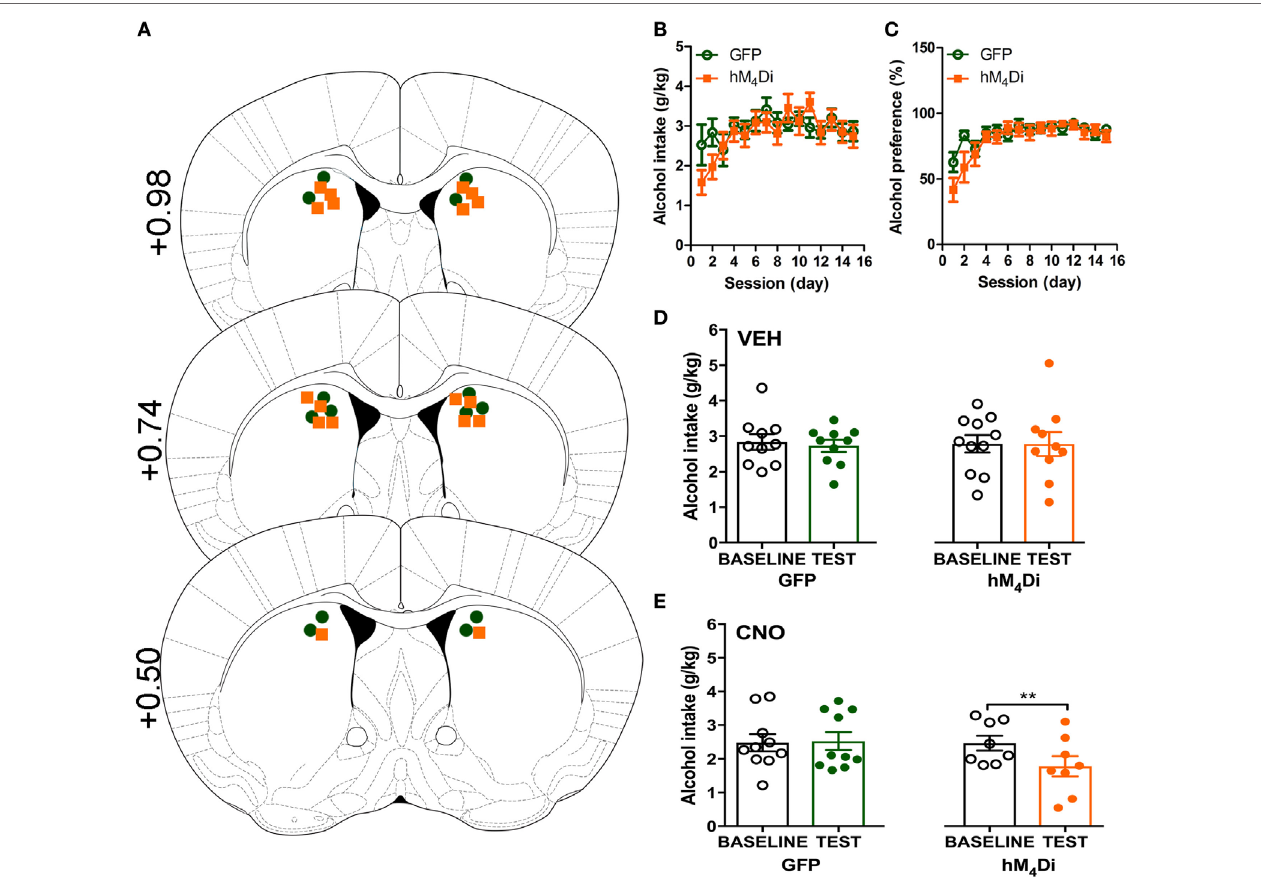
FigUre 1 | Activation of virally expressed hM 4 Di in the dorsal striatum decreases alcohol intake in mice. Cannula placement was verified for all animals included in behavioral analysis (a) . C57BL/6 mice ( n = 10–11) injected in the dorsal striatum with either AAV8-hSyn-EGFP (GFP) or AAV8-hSyn-hM 4 Di-mCherry (hM 4 Di) were trained to consume alcohol in a two-bottle, drinking-in-the-dark protocol. Both groups of animals displayed a similar increase in alcohol intake (B) and preference (c) . Vehicle injection (saline 0.9%, i.p.) did not change alcohol intake (D) . Systemic clozapine- N -oxide (CNO) injection (2 mg/kg i.p.) significantly decreased alcohol intake in mice expressing hM 4 Di, but not GFP, in the dorsal striatum (e) . Significance by unpaired, Student's t -test for AUC or two-way ANOVA with Bonferroni posttest for matching, ** p <